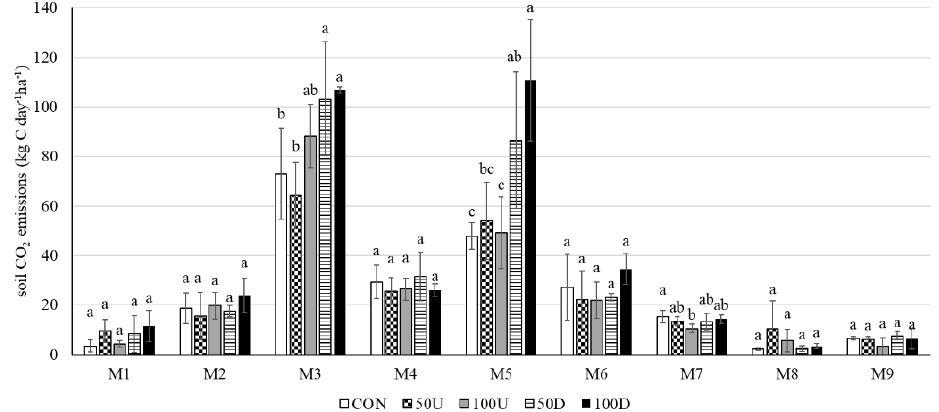
Figure 3. CO 2 emission fluxes (kg C day − 1 ha − 1 ) during the growing cycle for the control (CON), urea 50 kg N ha − 1 (50U), urea 100 kg N ha − 1 (100U), digestate 50 kg N ha − 1 (50D), and digestate 100 kg N ha − 1 (100D). Results that do not share letters are significantly different from each other ( p < 0.05).